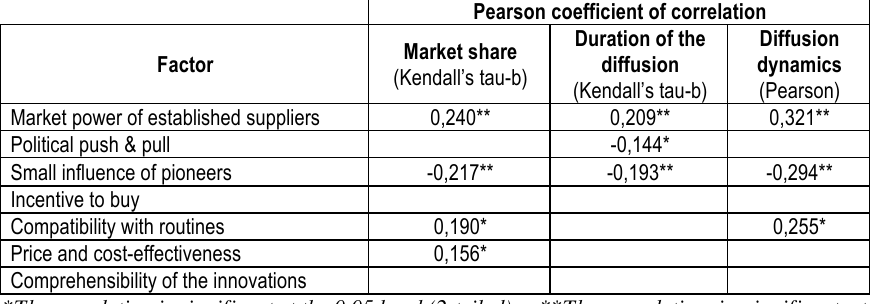
Table 5. Correlation between 7 independent variables and 3 dependent variables of 100 diffu- sion cases Pearson coefficient of correlation Duration of the Diffusion Market share Factor diffusion dynamics (Kendall’s tau-b) (Kendall’s tau-b) (Pearson) Market power of established suppliers 0,240** 0,209** 0,321** Political push & pull -0,144* Small influence of pioneers -0,217** -0,193** -0,294** Incentive to buy Compatibility with routines 0,190* Price and